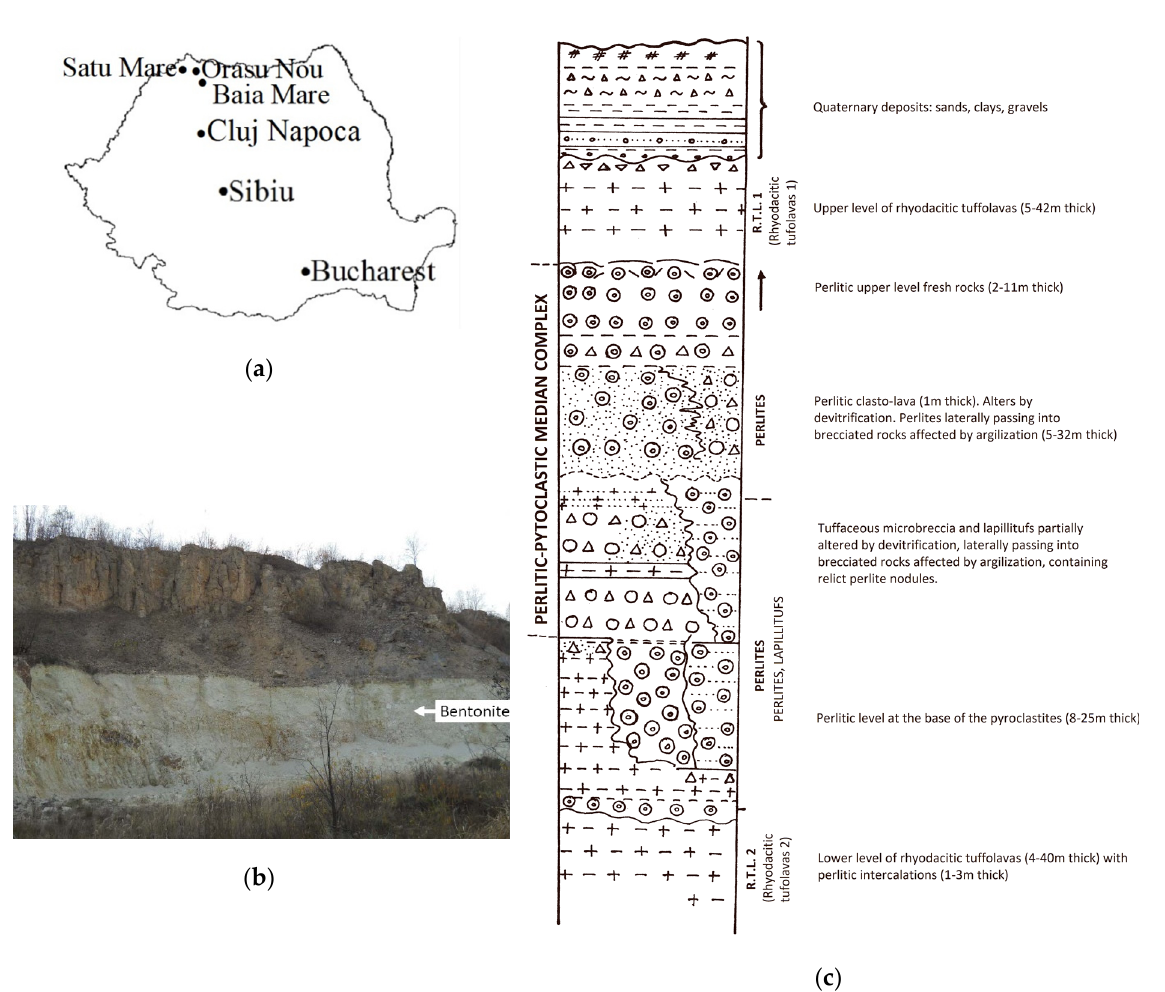
Figure 1. General view of the bentonite deposit from Ora ș u Nou. ( a ) Location of the bentonite deposit; ( b ) The bentonite layer exposed in one of the sampling quarries; ( c ) Synthetic litho-stratigraphic column representation of the geological formations.